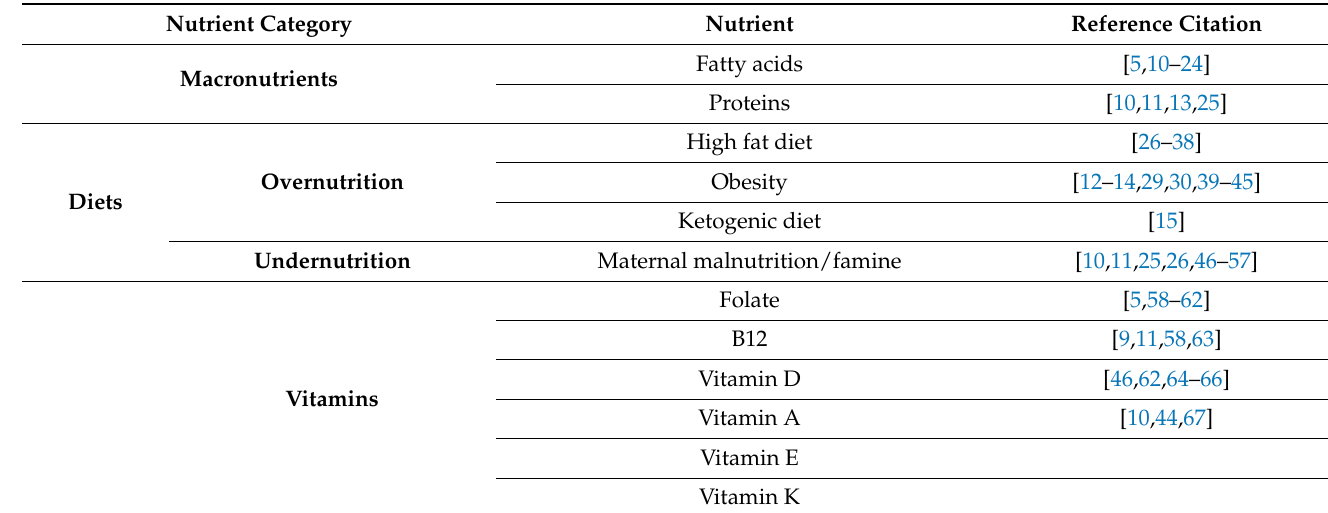
Figure 1. Prisma Flow Diagram. Table 1. Nutrients